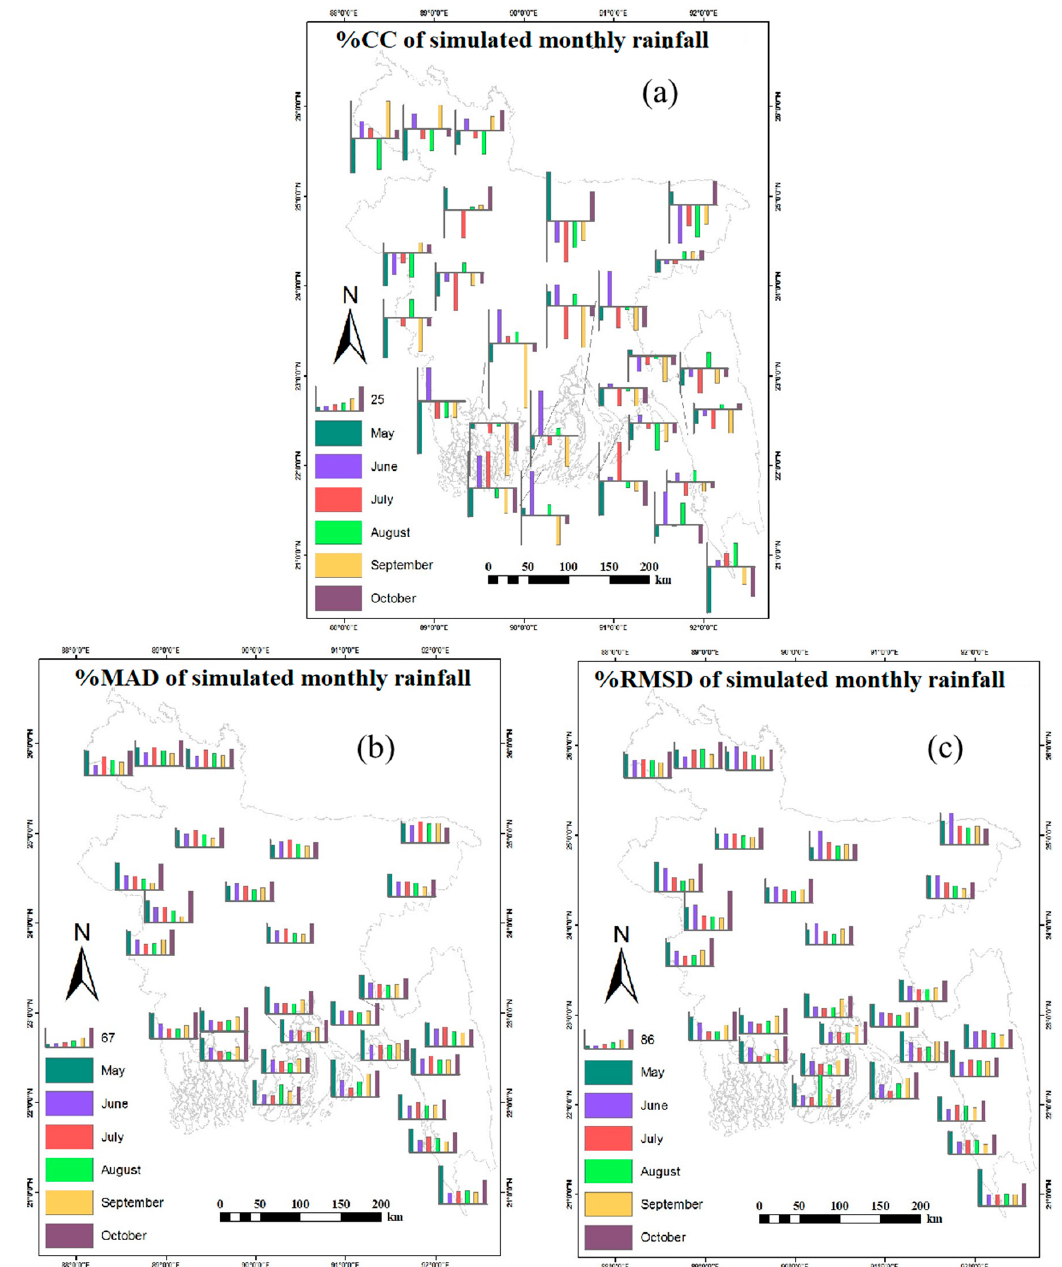
Figure 3. Performance of the PRECIS model in simulating monthly rainfall of Bangladesh. Here ( a ) CC denotes correlation coefficient, ( b ) MAD denotes mean absolute difference, and ( c ) RMSD denotes root mean square difference. The CCs, MADs and RMSDs are shown in bar diagrams for six months (May–October) after multiplying by 100.